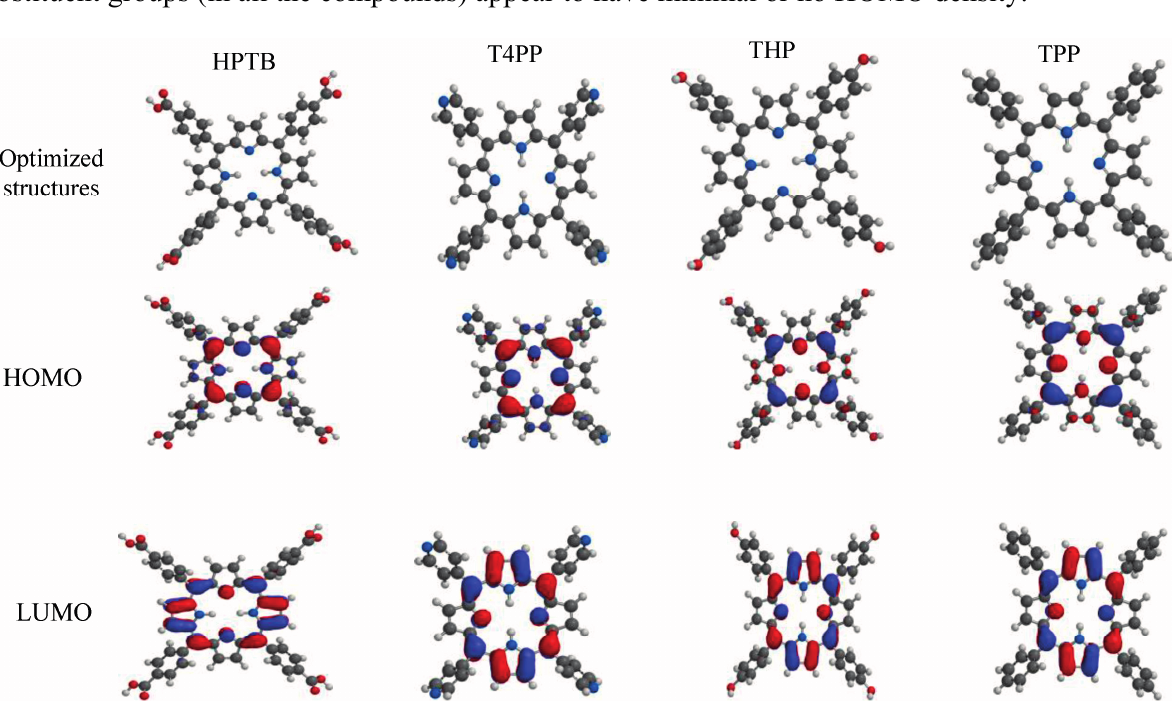
Figure 9. Optimized structures and the corresponding HOMO and LUMO electron density surfaces for the studied